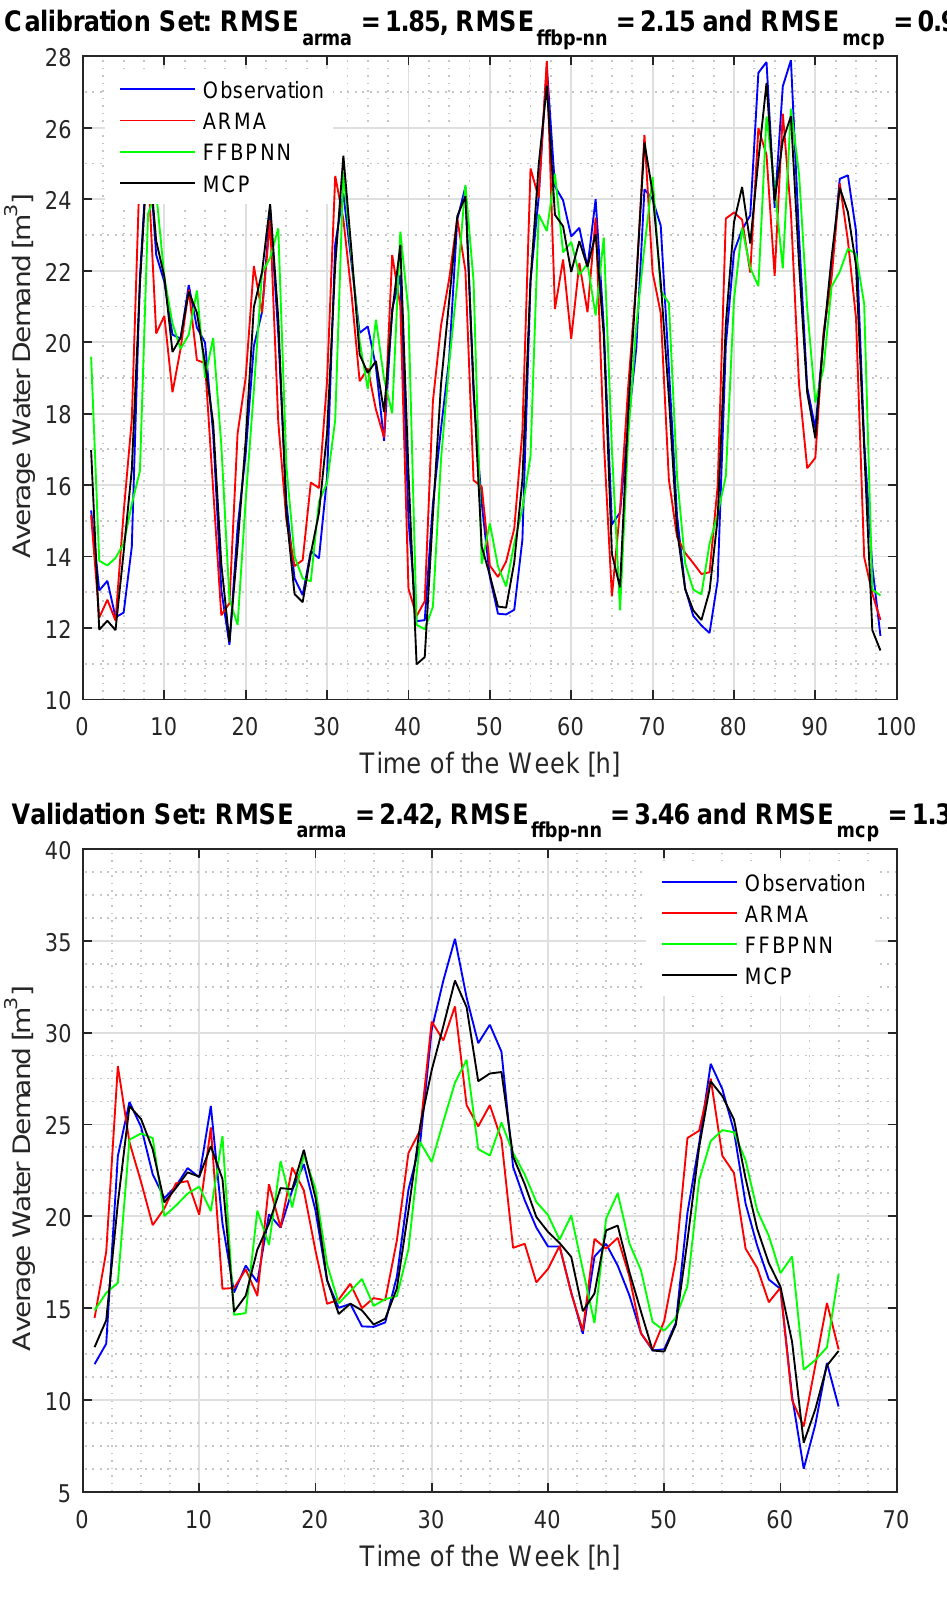
Figure 3. STWD forecasts generated ARMA, FFBP-NN and